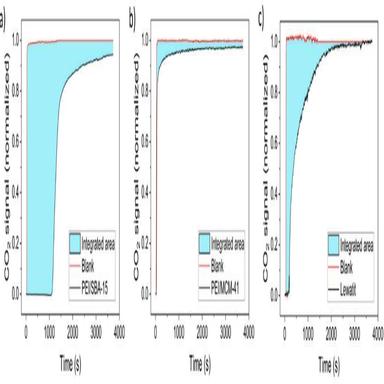
Breakthrough curves of CO2/He for (a) PEI/SBA-15, (b) PEI/MCM-41, and (c) Lewatit. The black curves represent the breakthrough curve, and the red curves are a blank run accomplished by running a breakthrough experiment through a parallel column of the same length under the same conditions.